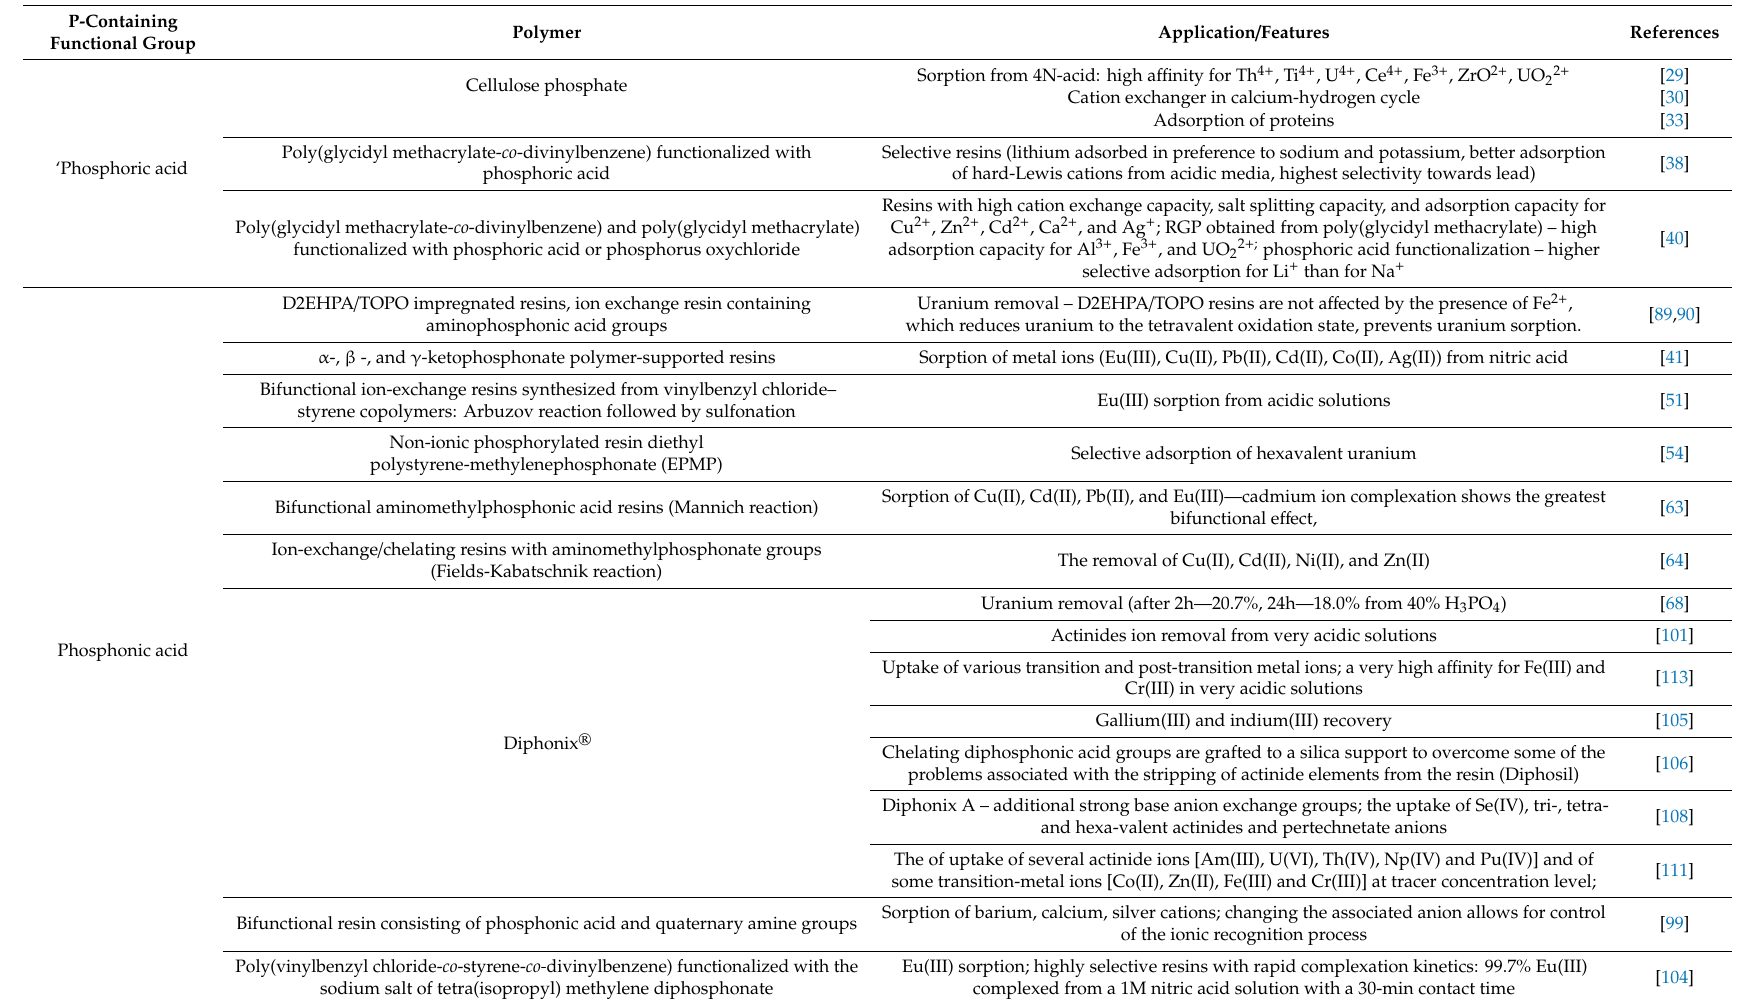
Table 2. The application of organophosphorus resin in separation processes—a collection of chosen